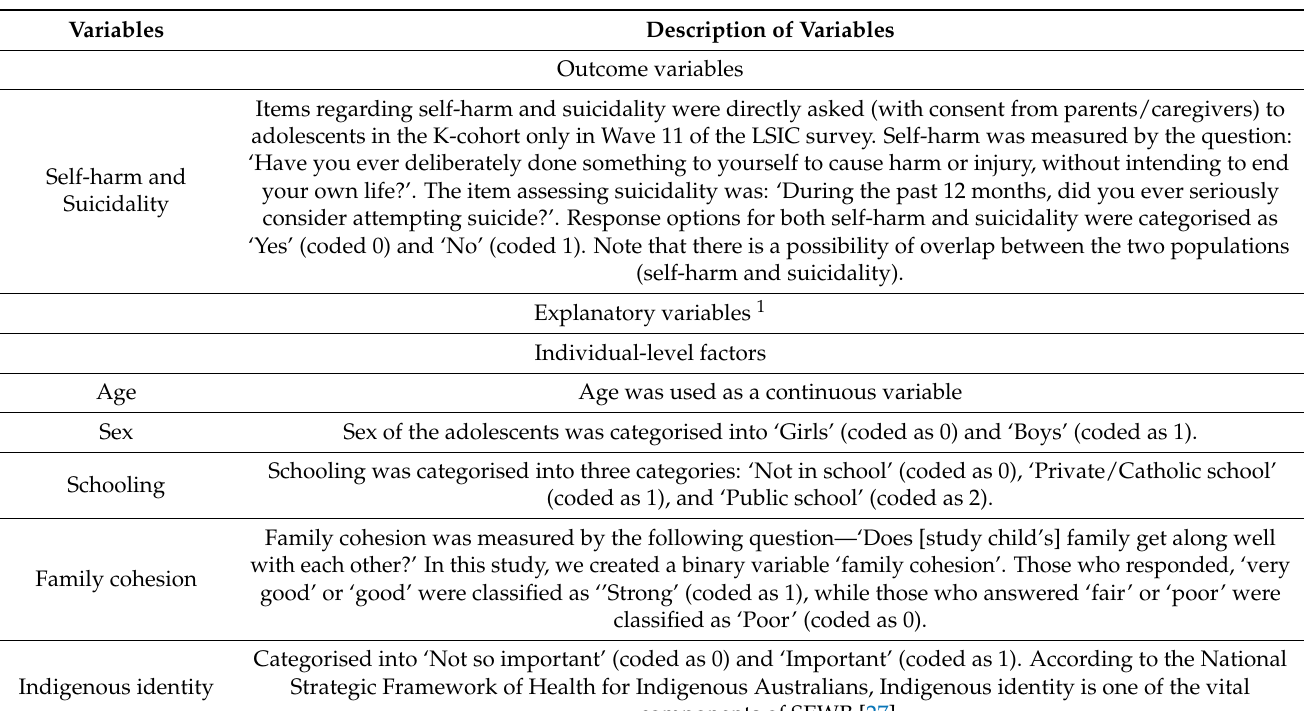
Table 1. List of